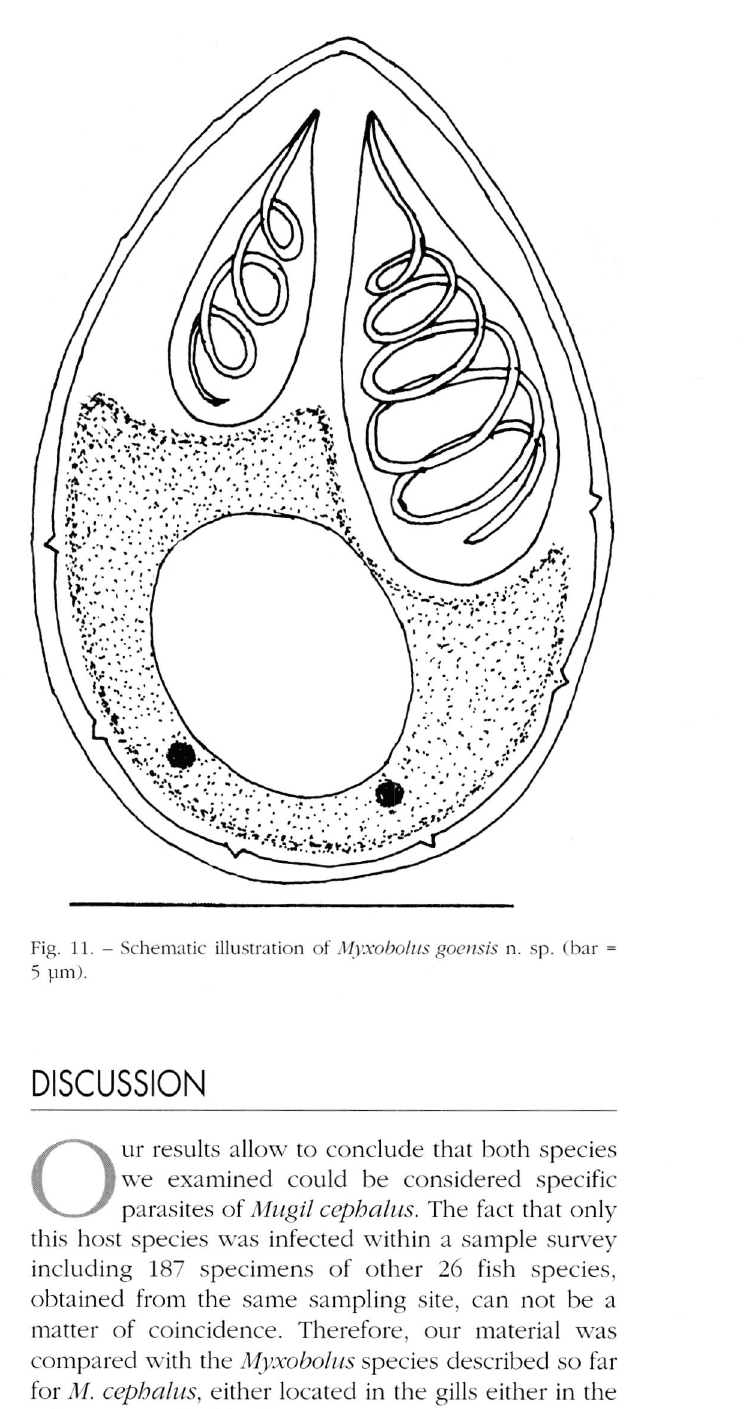
Fig. 11. - Schematic illustration of Myxobolus goensts n. sp. (bar = 5